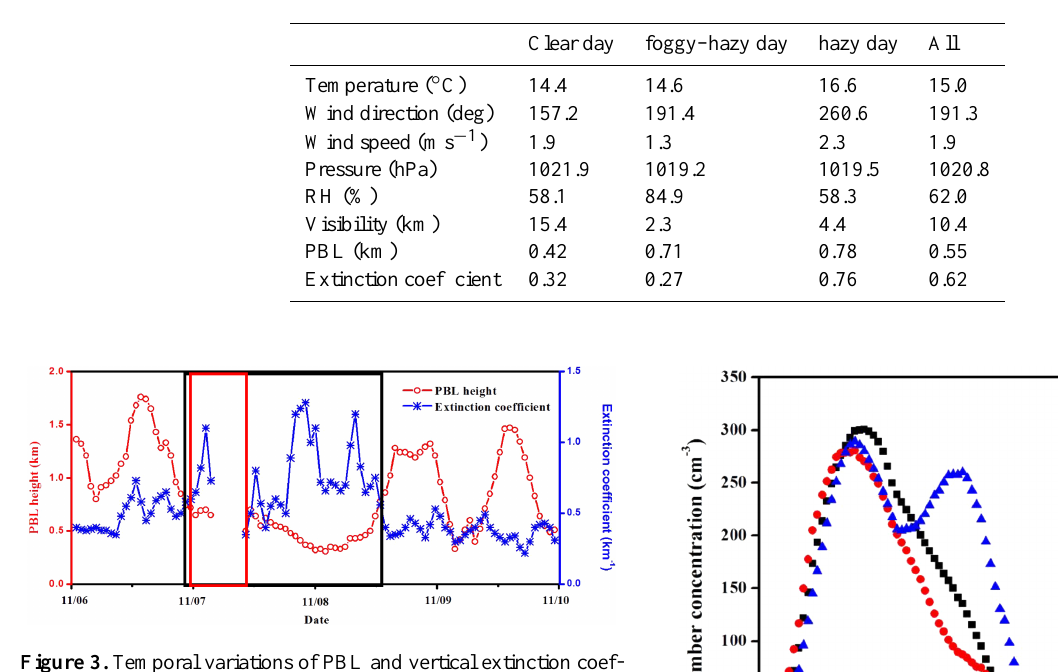
Table 1. Statistics of meteorological parameters in different weather conditions.